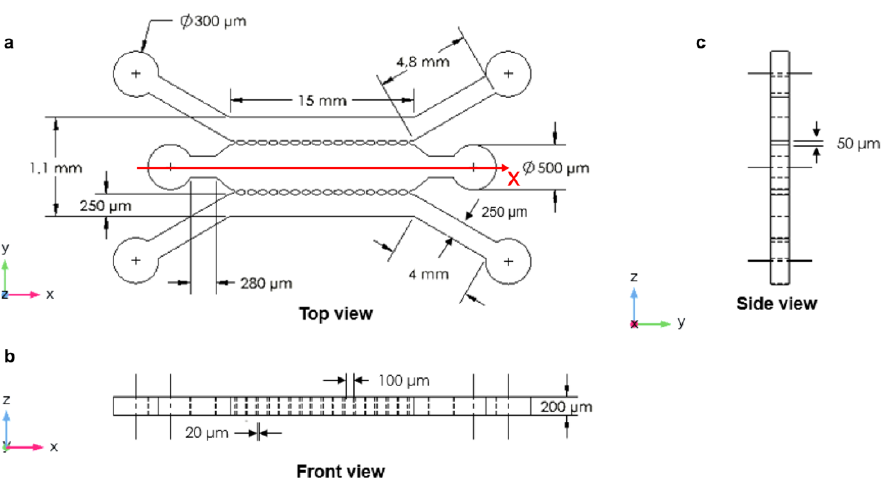
Figure 3. The three parallel microchannels: ( a ) top view with high micropillar magnification; ( b ) front view; ( c ) side view.